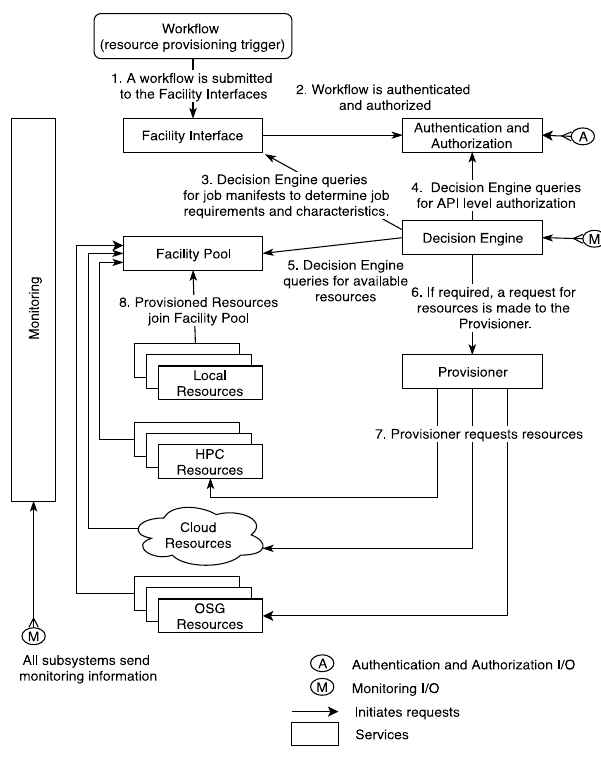
Fig. 1. Components involved in provisioning resources in the HEPCloud